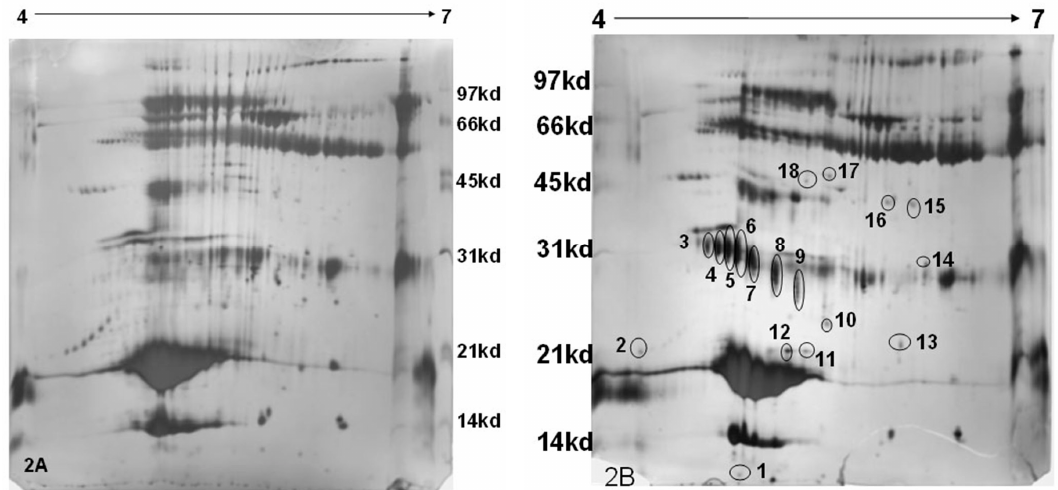
Figure 2. Two-dimensional (2D) gel electrophoresis of the whey protein of bovine milk and silver staining ((2A)—normal milk; (2B)—mastitis milk (M+)). Mastitis milk samples show differentially expressed proteins (1 to 18 spots).